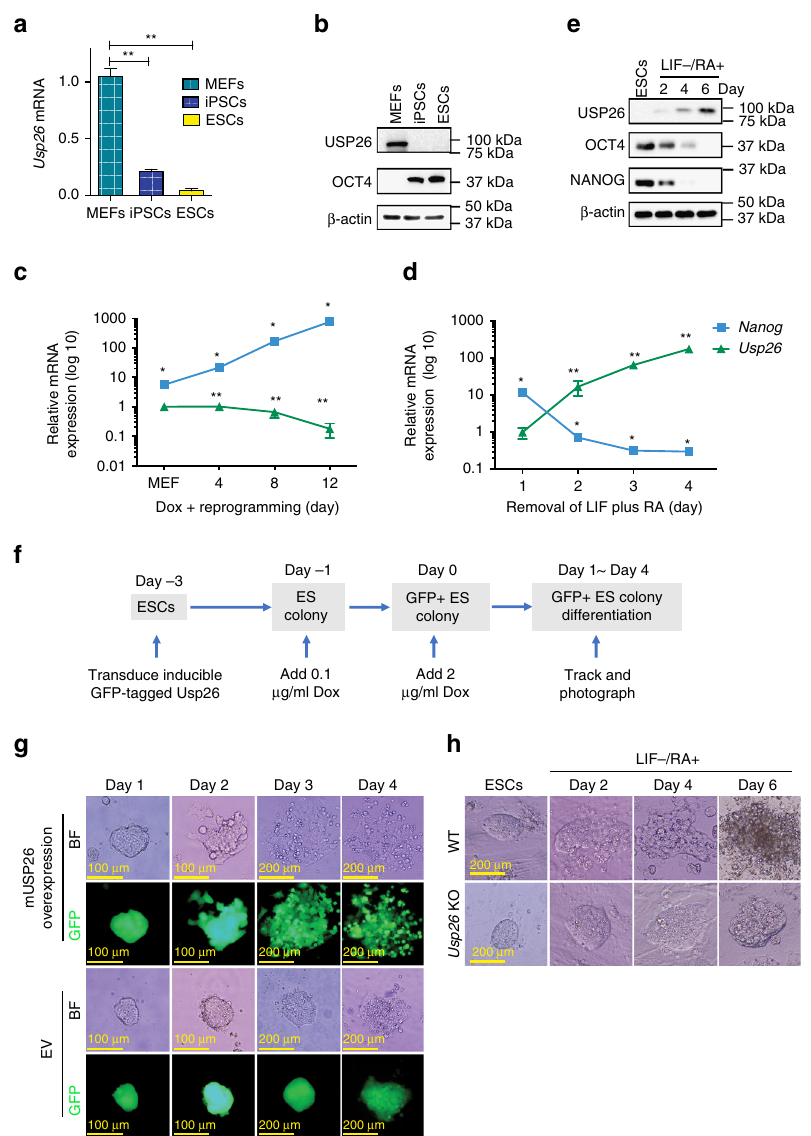
Fig. 2 USP26 is required for ESC differentiation. a Real-time qPCR analysis of mouse Usp26 mRNA expression in MEFs, iPSCs, and ESCs, ** p < 0.01 compared to MEFs. b Western blot analysis of USP26 protein expression in MEFs, iPSCs, and ESCs. c Real-time qPCR analysis of mouse Usp26 and Nanog mRNA expression during Dox-induced OSKM-mediated MEF reprogramming on days 0, 4, 8, and 12, * p < 0.05 compared to Usp26 , ** p < 0.05 compared to day 0. d Real-time qPCR analysis of mouse Usp26 and Nanog mRNA expression in ESCs after LIF withdrawal and treatment with 1 μ M RA on days 1, 2, 3, and 4, * p < 0.05 compared to Usp26 , ** p < 0.05 compared to day 1. e Western blot analysis of USP26, OCT4, and NANOG protein expression in ESCs after LIF withdrawal and treatment with 1 μ M RA at days 0, 2, 4, and 6. β -actin was used as a loading control. f Experimental scheme of Usp26-induced ESC differentiation. ES cells were transduced with Dox-inducible GFP-tagged Usp26 or empty vector lentivirus. After ESC colonies formed, then low-dose Dox (0.1 µ g/ml) was added for 1 day pre-selection. Day 0 was de fi ned as the day when pre-selected GFP-positive colonies were cultured in iSF1 medium with high-dose Dox (2 µ g/ml), individual colonies were tracked and taken pictures on Usp26-expressing days 1, 2, 3, and 4. g Bright fi eld (BF) and fl uorescent microscopic images of ESC morphology with Dox-inducible GFP-tagged m Usp26 overexpression or with GFP-tagged empty vector (EV). h Bright fi eld images of ESC morphology of wild-type (WT) or Usp26 knockout (KO) ESCs treated with RA. WT or Usp26 KO ESCs were cultured in ES differentiation medium (LIF withdrawal with 1 μ M RA). Individual colonies were tracked and photographed on days 0, 2, 4, and 6 under microscope. The data are presented as means ± SD from three independent experiments. a , c , d Two-way ANOVA for multiple comparisons from Dharmacon mouse shRNA library (with a GFP expression after doxycycline (Dox) induction for 12 days (Fig. 1a). cassette in the vector) were selected based on their ability to knockdown their corresponding genes. We used at least two individual shRNAs of each gene with high knockdown ef fi ciency ( > 70%) for screening. Dox-inducible Oct4-Sox2-Klf4-cMyc (OSKM) transgenic MEFs were transduced with individual lentiviral shRNAs speci fi c for USP gene. The reprogramming ef fi ciency was determined by alkaline phosphatase (AP) staining NATURE COMMUNICATIONS | 8: